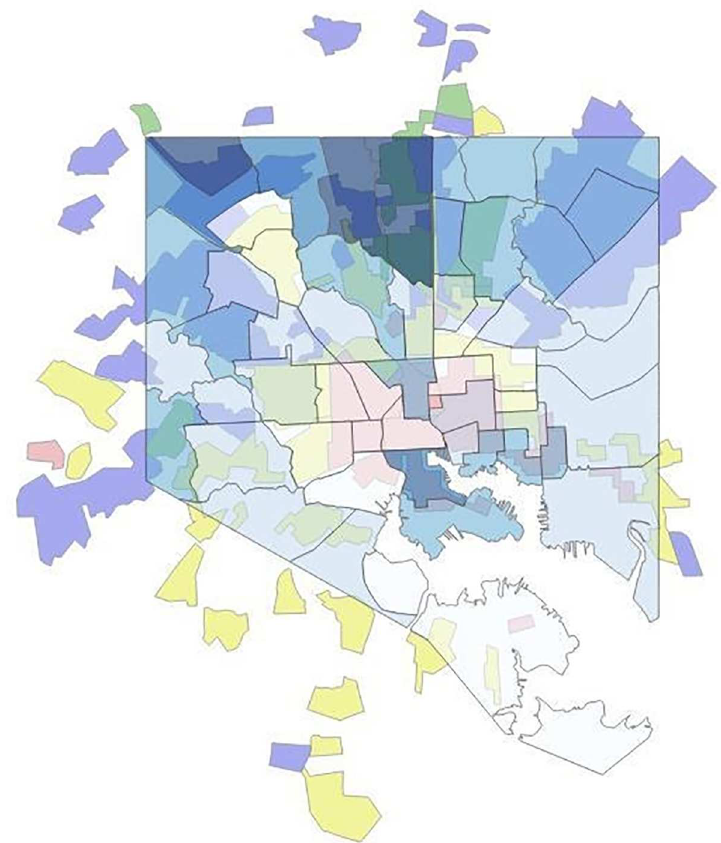
Fig 3. 2013 Baltimore CSAs’ life expectancy overlaid on top of HOLC redlining map. HOLC redlining map republished from Nelson RK, Winling L, Marciano R, Connolly N, et al. Mapping Inequality. n.d. [cited 2017 Nov 6].